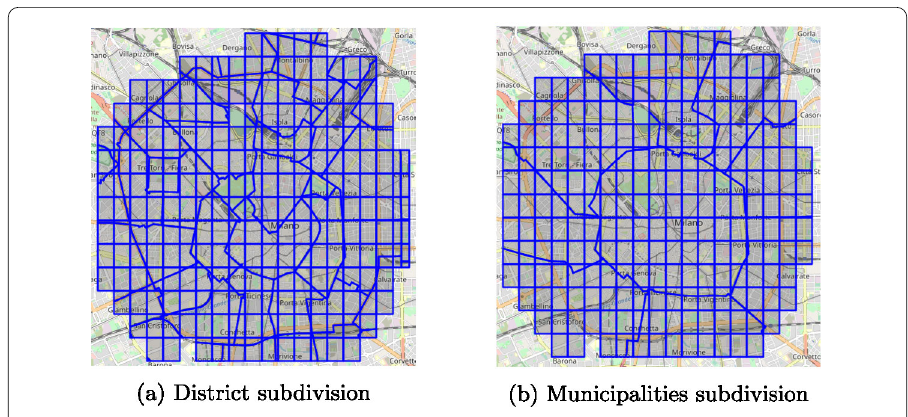
Figure 5 The two different aggregations of the areas